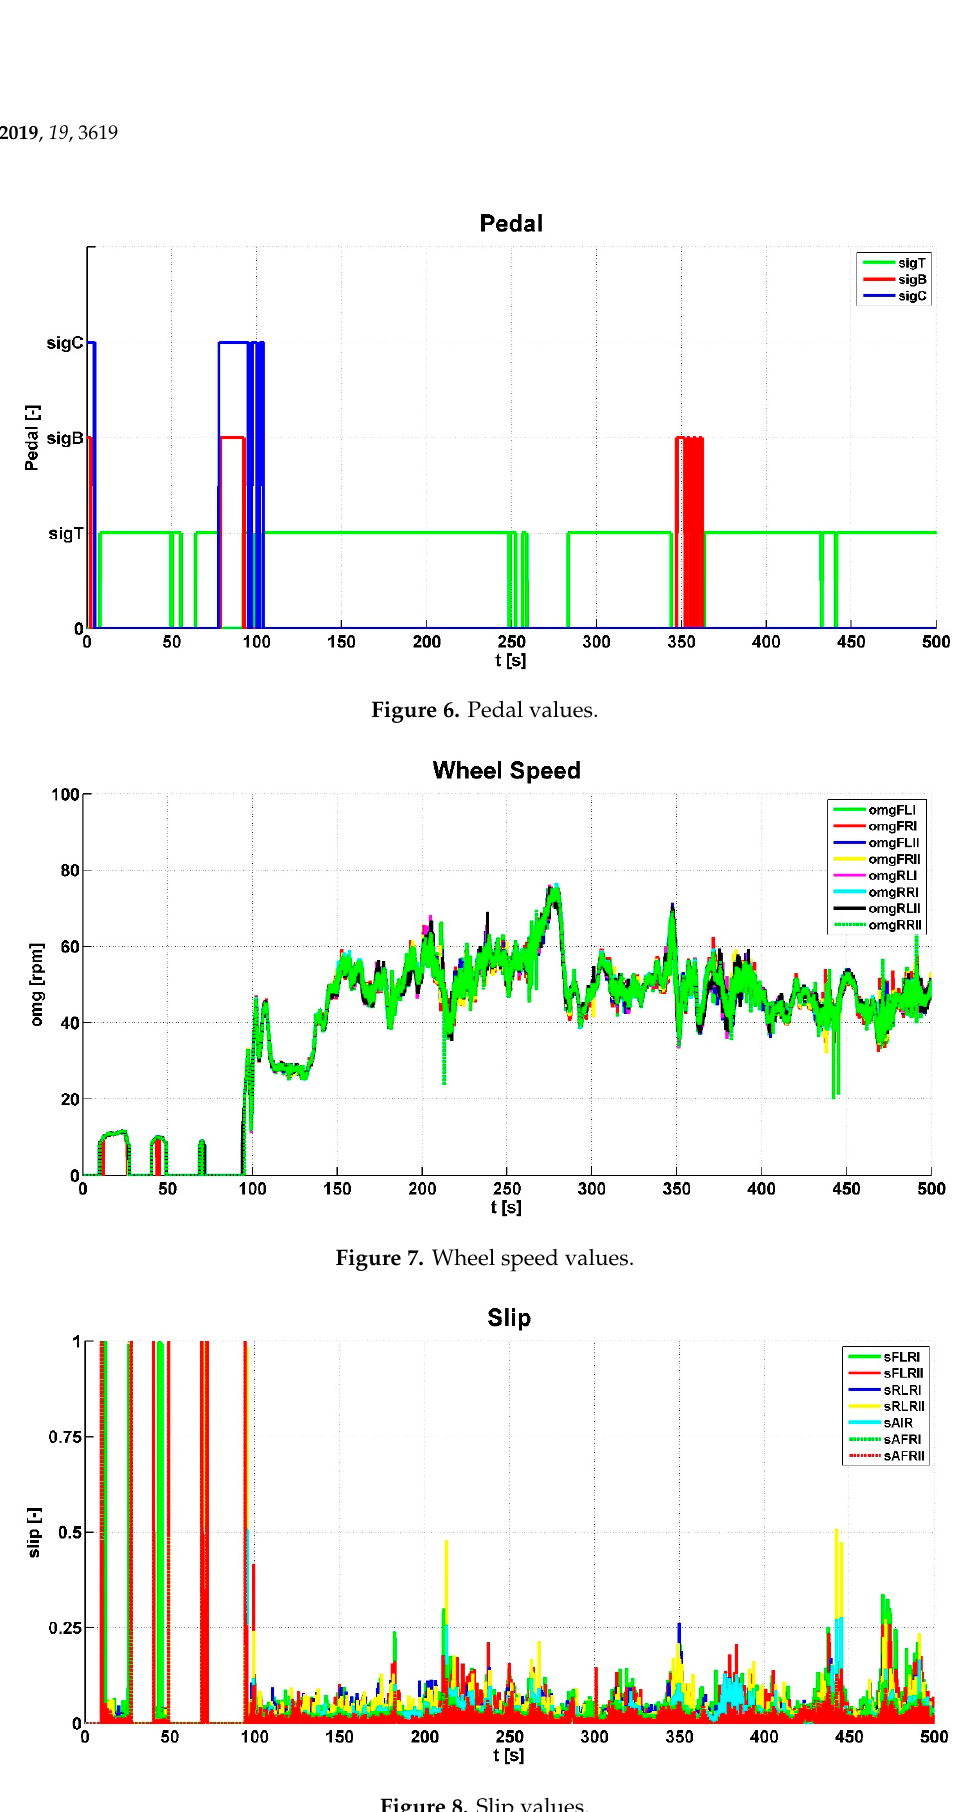
Figure 8. Slip Figure 8. Slip values. Figure 8. Slip values.